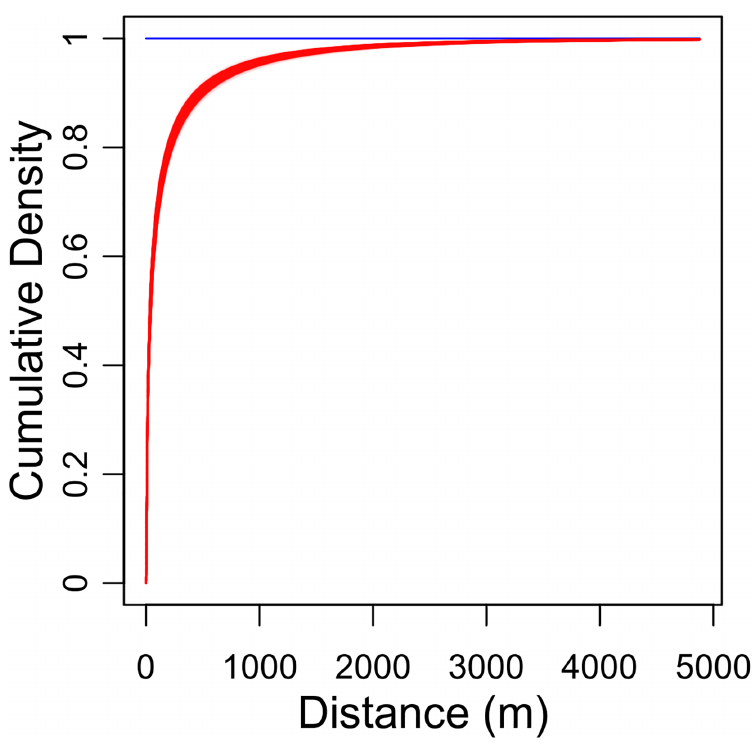
Fig 6. Estimated dispersal kernel for the sharka epidemic. The posterior marginal cumulative distribution function, F 1 D , of the fitted dispersal kernel, obtained for κ = 11 (i.e. the number of introduction patches maximising the Fisher information). The plotted posterior distribution was obtained from 4000 MCMC samples. One line is plotted per